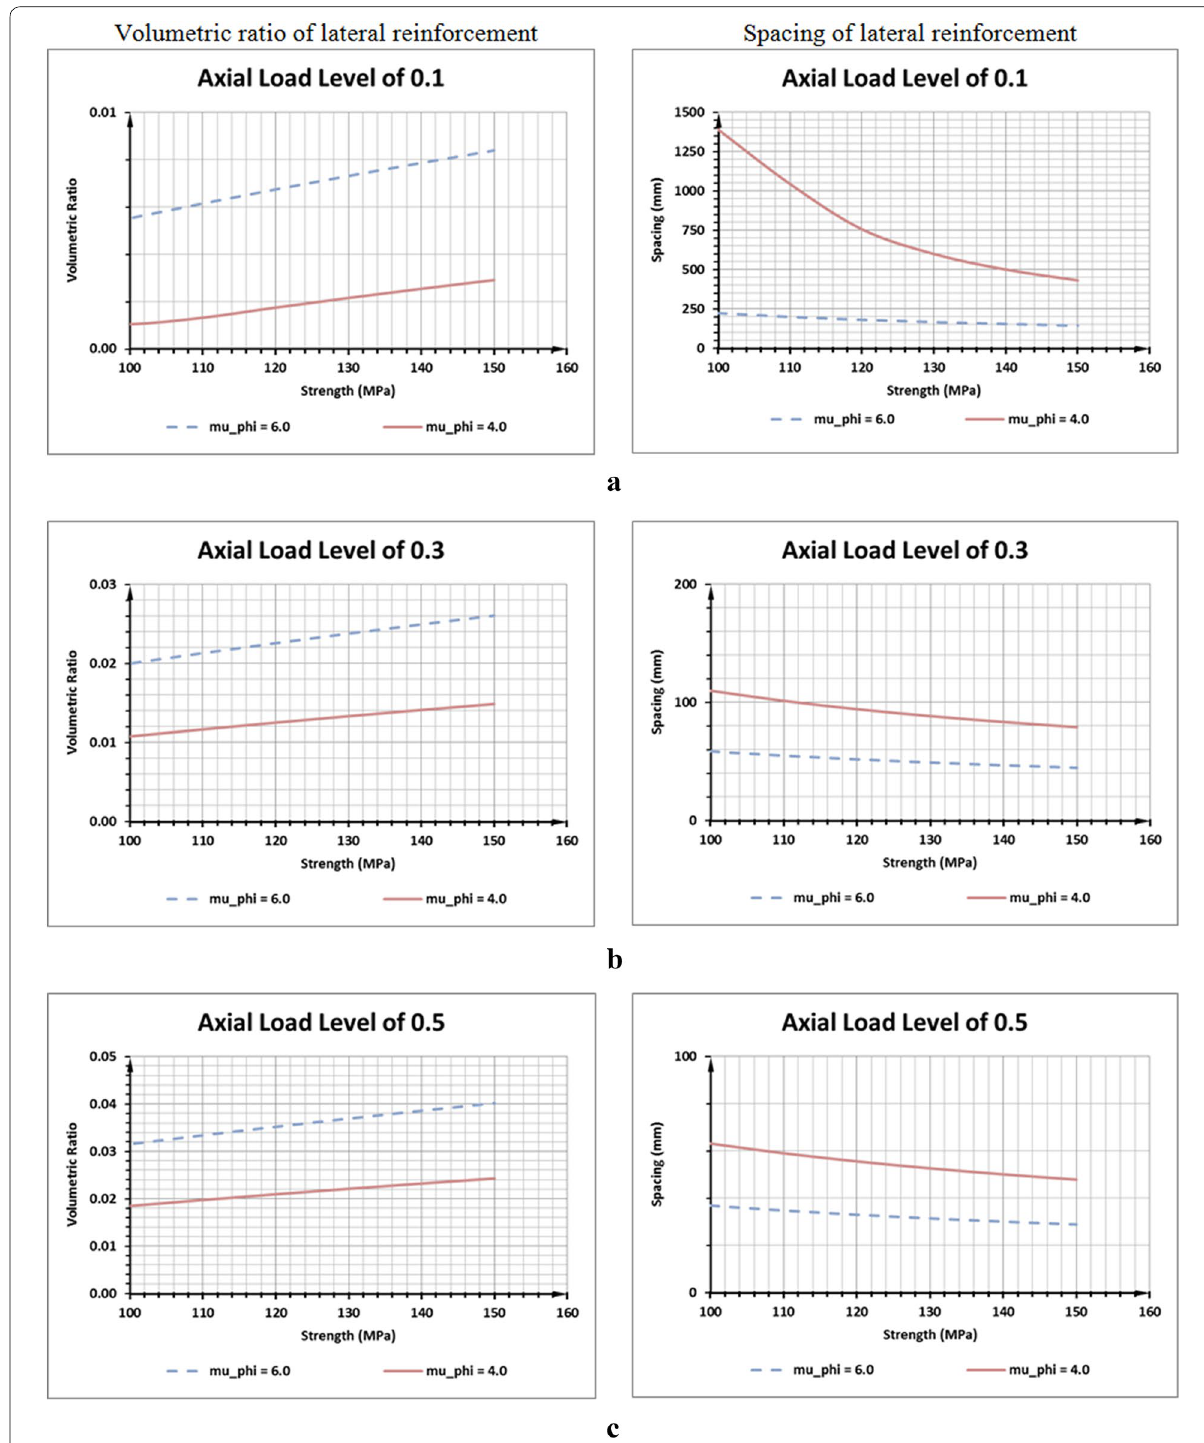
Fig. 10 Required volumetric ratio of transverse steel for different ductility levels ( µ φ P /f co A c 0.1, b P /f co A c =